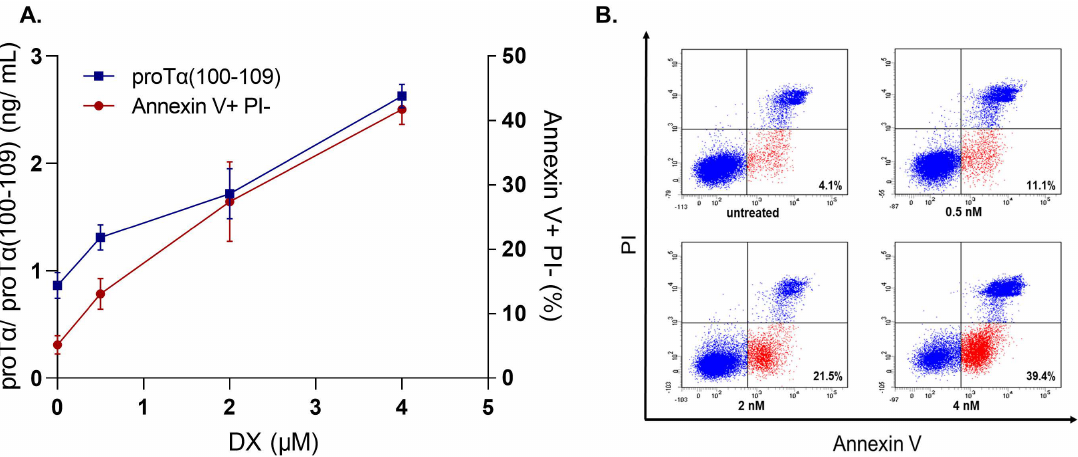
Figure 3. The levels of proT α (100–109) correlate with the percentages of early apoptotic MCF-7 human breast cancer cells treated with doxorubicin (DX). ( A ) An overlay chart, showing the concentration of the peptide as determined in MCF-7 culture supernatants (left axis) versus the percentages of early apoptotic (Annexin V+ PI − ) MCF-7 cells (right axis). MCF-7 cells were treated with DX (0.5, 2 and 4 µ M) for 48 h at a cell density of 1 × 10 6 cells/mL. Values are means ± SD from three individual experiments performed. ( B ) Representative dot plots from one experiment with MCF-7 cells treated with DX. Cells were stained with Annexin V/PI and analyzed using BD FACSDiva software. Numbers in the low right quadrats show the percentages of early apoptotic cells.